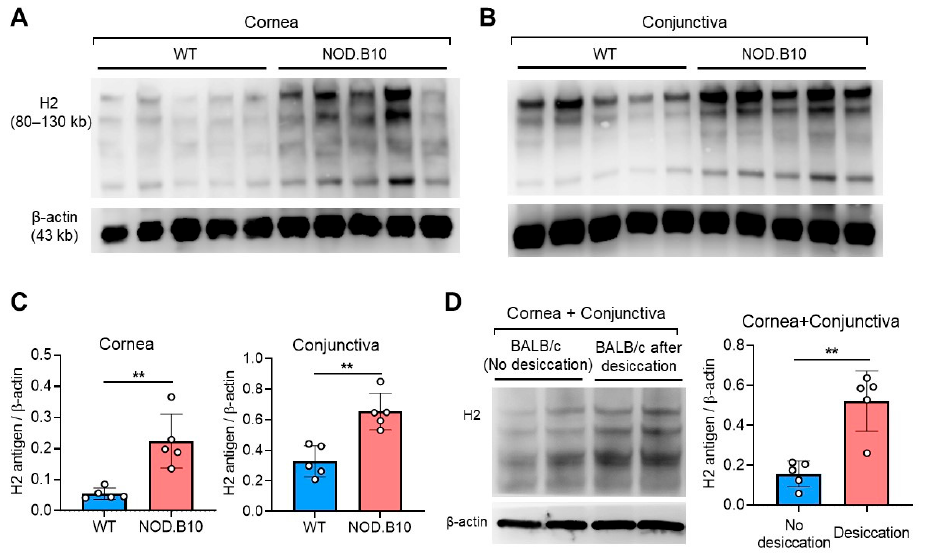
Figure 1. H2 antigen expression in the cornea and conjunctiva in two murine DED models. ( A , B ) Western blot images for H2 antigen in the cornea ( A ) and conjunctiva ( B ) in wild-type (WT) C57BL/6 and NOD.B10.H2 b (NOD.B10) mice at 12 weeks of age. ( C ) Densitometric analysis of the ratio of H2 antigen expression relative to β actin. ( D ) Representative Western blot image and quantitative densitometric analysis of H2 antigen in the cornea and conjunctiva in 30-week-old BALB/c mice under physiological condition (without desiccating stress) or under desiccating stress. A circle represents the data from a single individual animal. Bar depicts mean ± SD. ** p < 0.01.